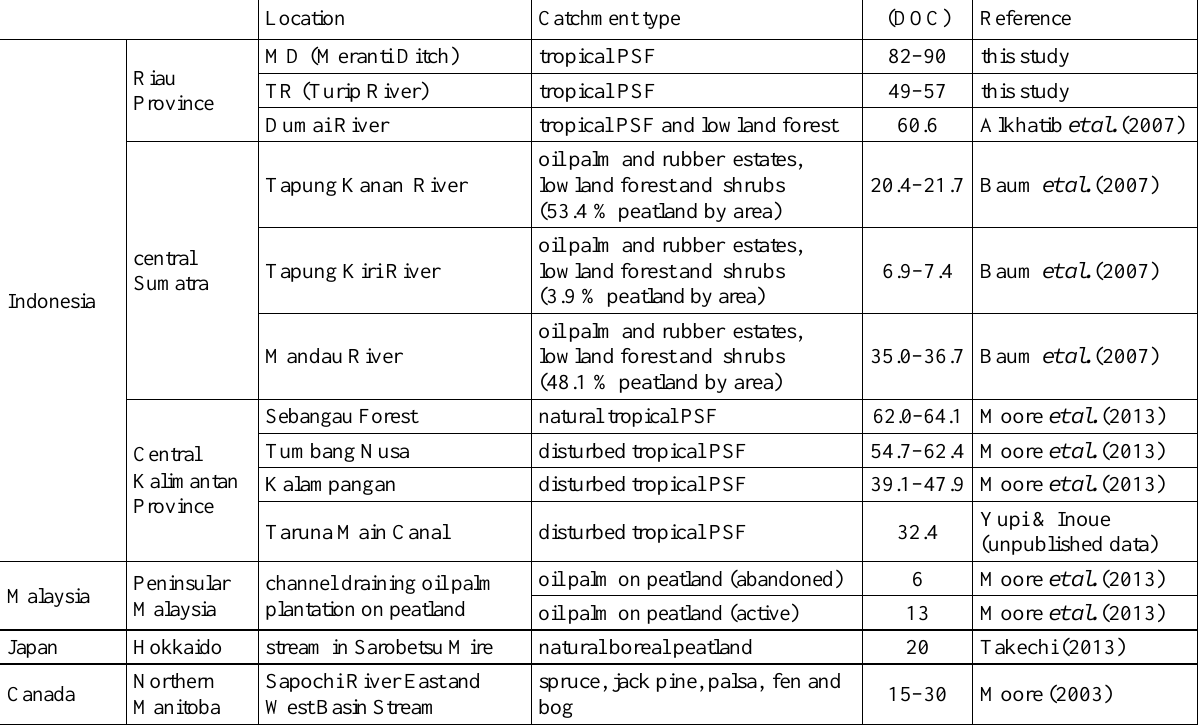
Table 5. DOC concentrations ((DOC), mg C L -1 ) in streamwater within different regions/catchment